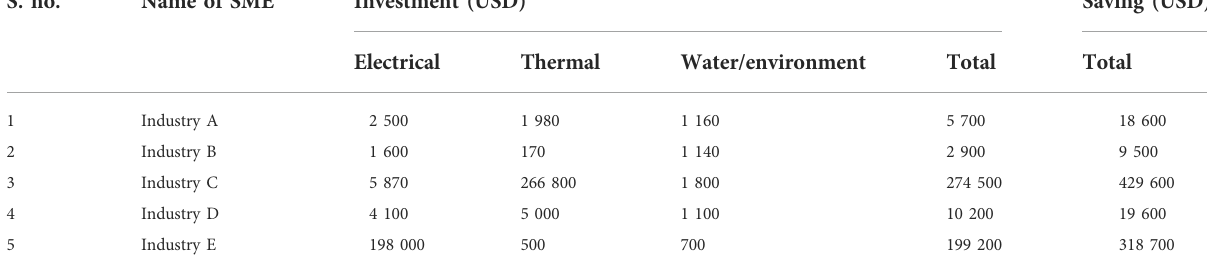
TABLE 9 Total fi nancial investments and savings from implementation of smart environmental management practices (SEMPs). S.